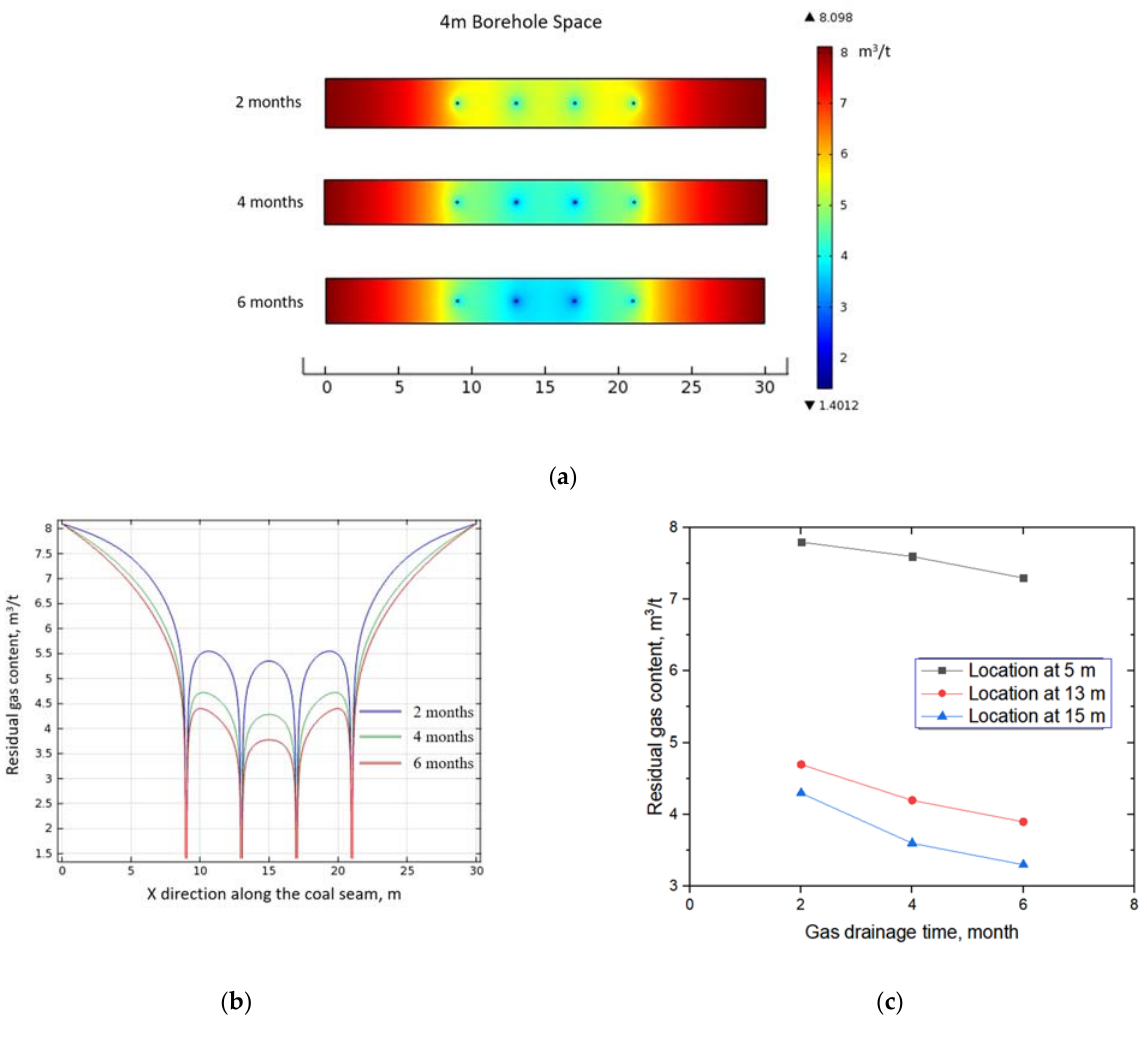
Figure 8. Simulation results of 4 m borehole. ( a ) Gas content contour; ( b ) residual gas content with respect to X direction along the coal seam; ( c ) gas content at three points with respect to gas drainage time.